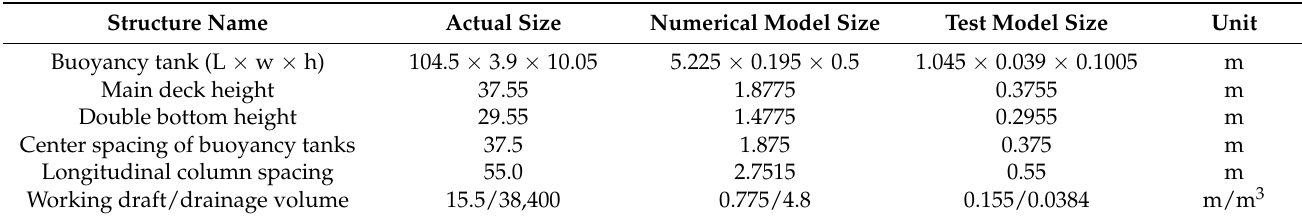
Figure 2. Semi-submersible platform. ( a ) Numerical platform configuration. ( b ) Test platform model. Table 2. Dimensions of platform body and model.